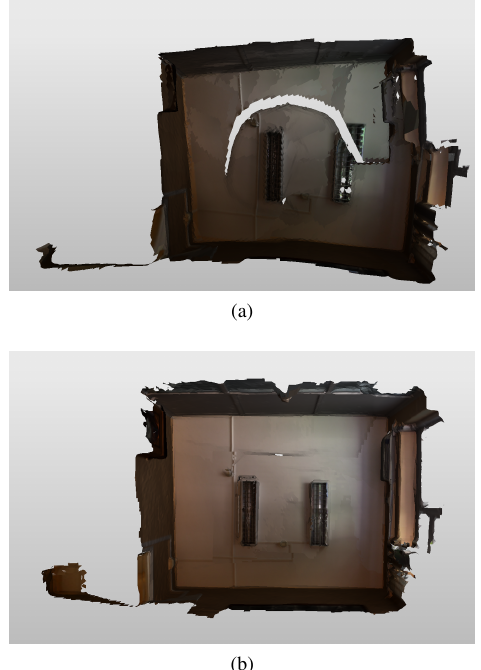
Figure 1: 3D model of a room ceiling: (a) not correct tracking, (b) correct tracking.